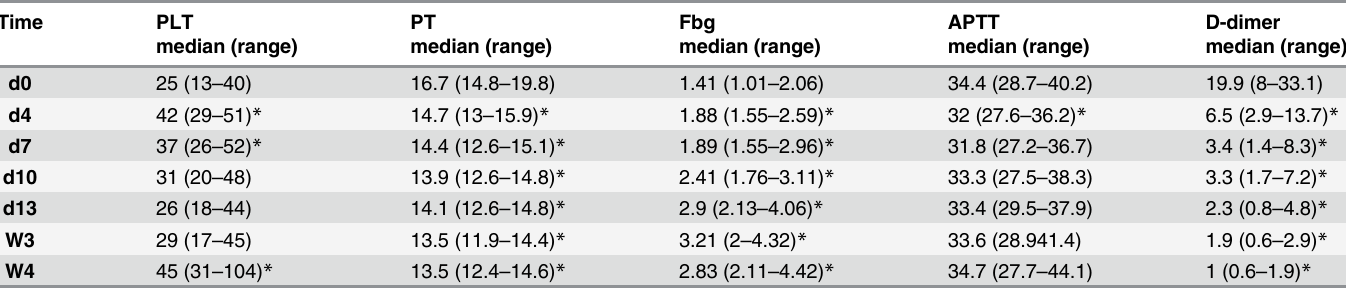
Table 2. Change in the trend of hemostatic parameters in patients with